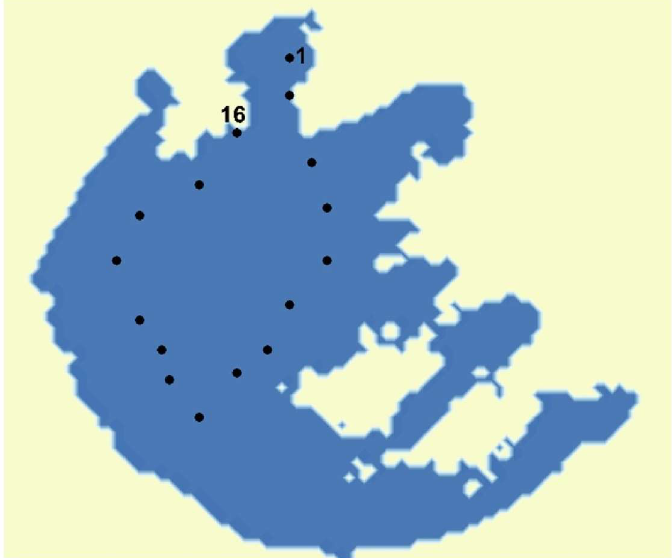
Figure 2. Locations of the stations where the total suspended particulate matter (TSM) was measured.